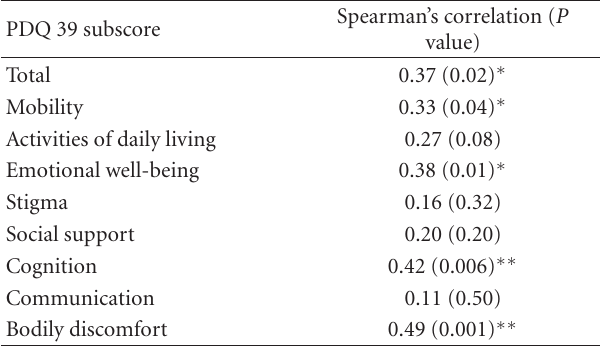
Table 2: Correlation of Fatigue Severity Scale with Parkinson Dis- ease Questionnaire (PDQ) 39